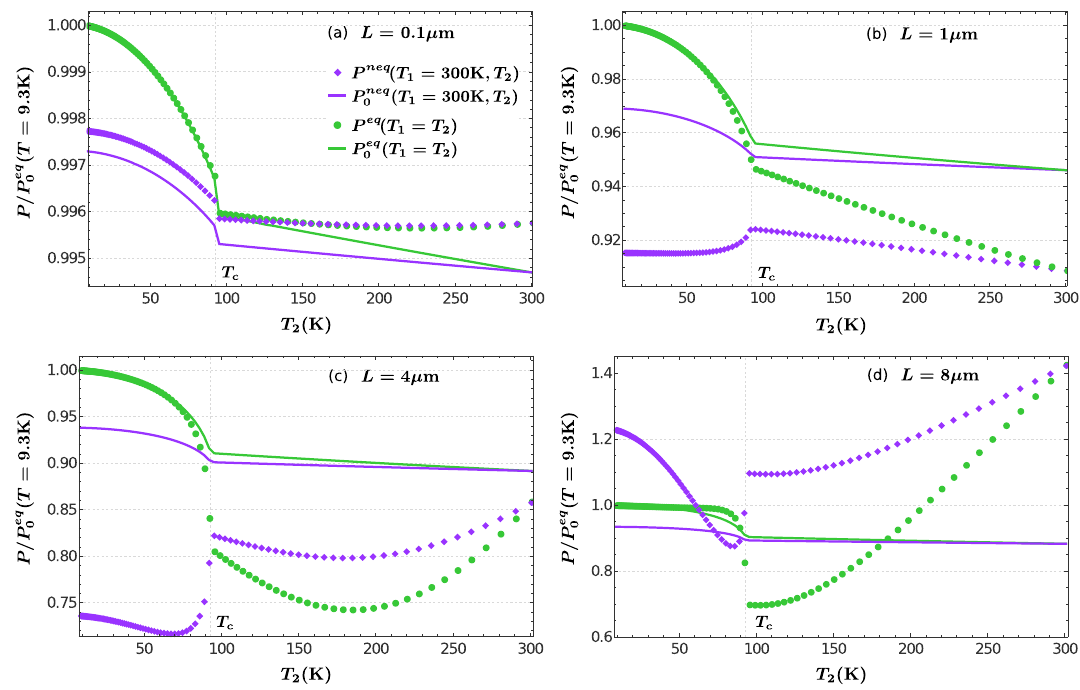
Figure 3. Temperature dependence of the equilibrium P eq and nonequilibrium P neq Casimir pressures for fixed separation distances of ( a ) L = 0.1 µ m, ( b ) L = 1 µ m, ( c ) L = 4 µ m, and ( d ) L = 8 µ m. The vertical axis of each figure is normalized to the corresponding zero-point pressure existing within two plates at 9.3 eq ( 0.1 µ m ) = 2.95N / m 2 , P eq ( 1 µ m ) = 6.78 × 10 − 4 N / m 2 , P eq ( 4 µ m ) = 3.88 × 10 − 6 N / m 2 , and K: P 0 0 0 ( 8 µ m ) = 2.72 × 10 − 7 N / m 2 P eq 0